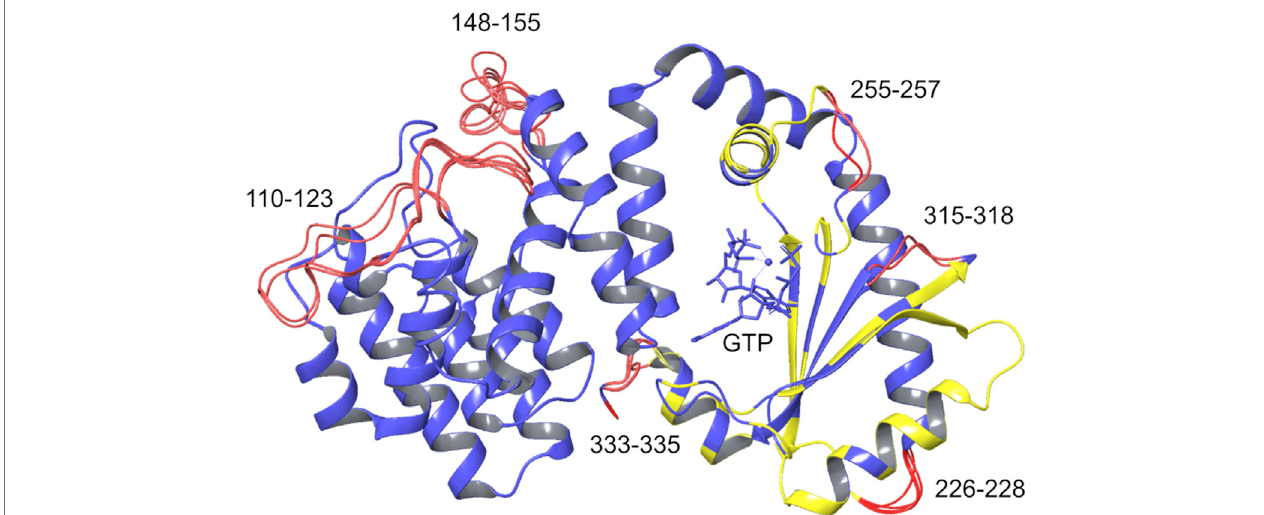
FIGURE4| Chimeramodelsgenerated.The fi vechimeramodelsgeneratedbyhomologymodelingareoverlaid.Blue:coordinatestakenfromthetemplate;yellow: coordinates taken from the template with optimized side chains; red: rebuilt residues. GTP, AMP-CPP, and the Mg 2+ ion (blue sphere) are shown within the SYNTH binding site.